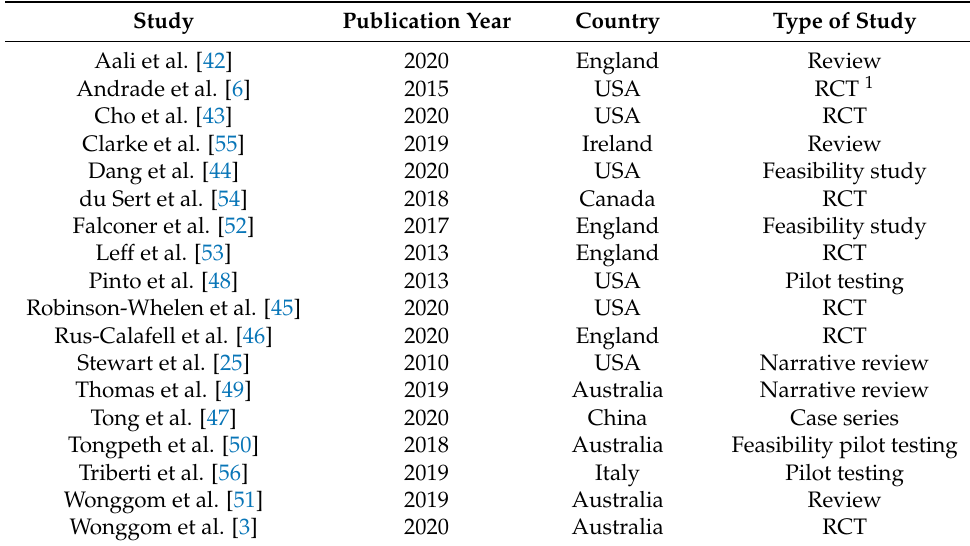
Figure 1. Systematic review of the literature flowchart. Table 1. Characteristics of included